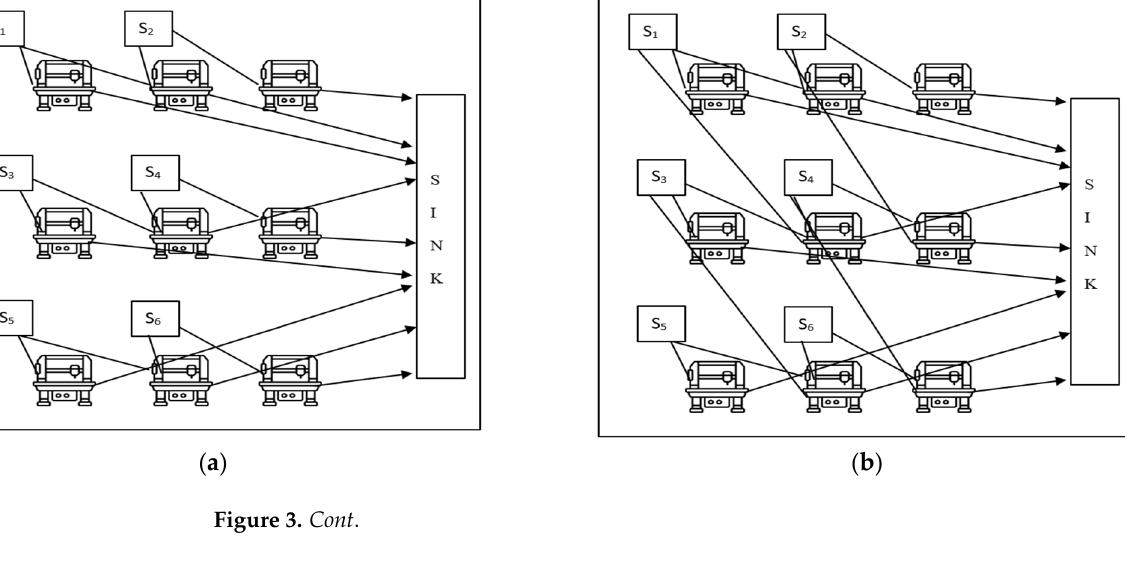
( d ) Figure 3. Flexible-configuration machine systems. ( a ) One-degree flexible system. ( b ) Two-degree flexible system. ( c ) Semi-flexible system. ( d ) Fully flexible system. 4.1. Experimental Analysis The values of each parameter have been calculated by considering the number of jobs as 5000 and, as mentioned below in Table 2, to obtain that level a majority of machines break down at least once. Throughput time is the actual time taken to manufacture a prod- uct, and it can be calculated by multiplying the average stay time by the total number of jobs per machine compared with the existing literature values [9]; similarly, throughput rate is the rate at which units move from start to finish, and it can be calculated by dividing the output by the Throughput Time. The Availability is the amount of time in which the machine runs and is available for production, and can be calculated by Equation (1). MTBF Availability (1) The average stay time and Maximum Stay Time can be calculated from the bell curve by considering a 99.97% confidence level since the processing time follows the normal distribution. The system use can be defined as the proportion of time that the manufac- turing system is used, and system use is calculated by Equation (2).